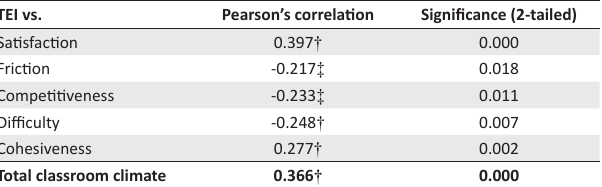
TABLE 5: Pearson’s correlation between trait emotional intelligence and the classroom climate scores ( n = 119). TEI